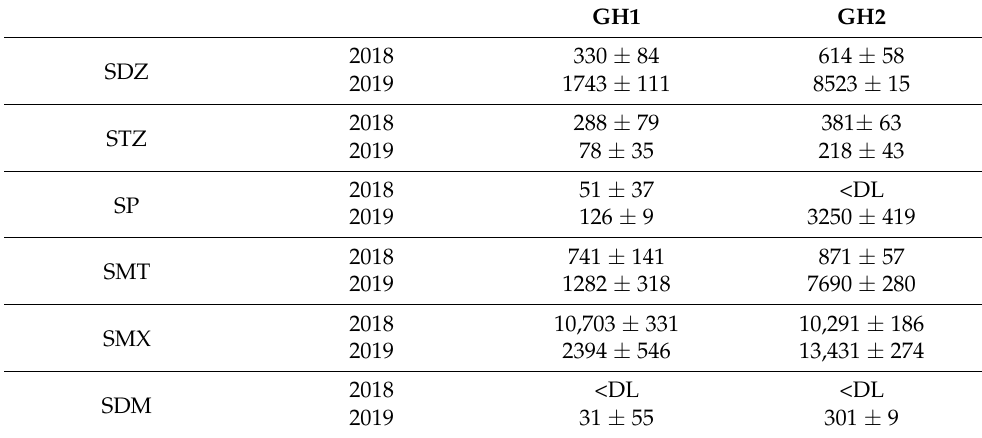
Table 4. Concentration of sulfonamides (sulfadiazine (SDZ), sulfathiazole (STZ), sulfapyridine (SP), sulfamethizole (SMT), sulfamethoxazole (SMX) and sulfadimethoxine (SDM)) in soil (ng kg − 1 ) over two years. Data are represented as the mean ± standard deviation, n = 3. <DL indicates below the detection limit. GH1 GH2 2018 330 ± 84 614 ± 58 SDZ 2019 1743 ± 111 8523 ± 15 2018 288 ± 79 381 ± 63 STZ 2019 78 ± 35 218 ± 43 2018 51 ± 37 <DL SP 2019 3250 ± 419 2018 741 ± 141 871 ± 57 SMT 2019 1282 ± 318 2018 SMX 2018 <DL <DL SDM 2019 31 ±